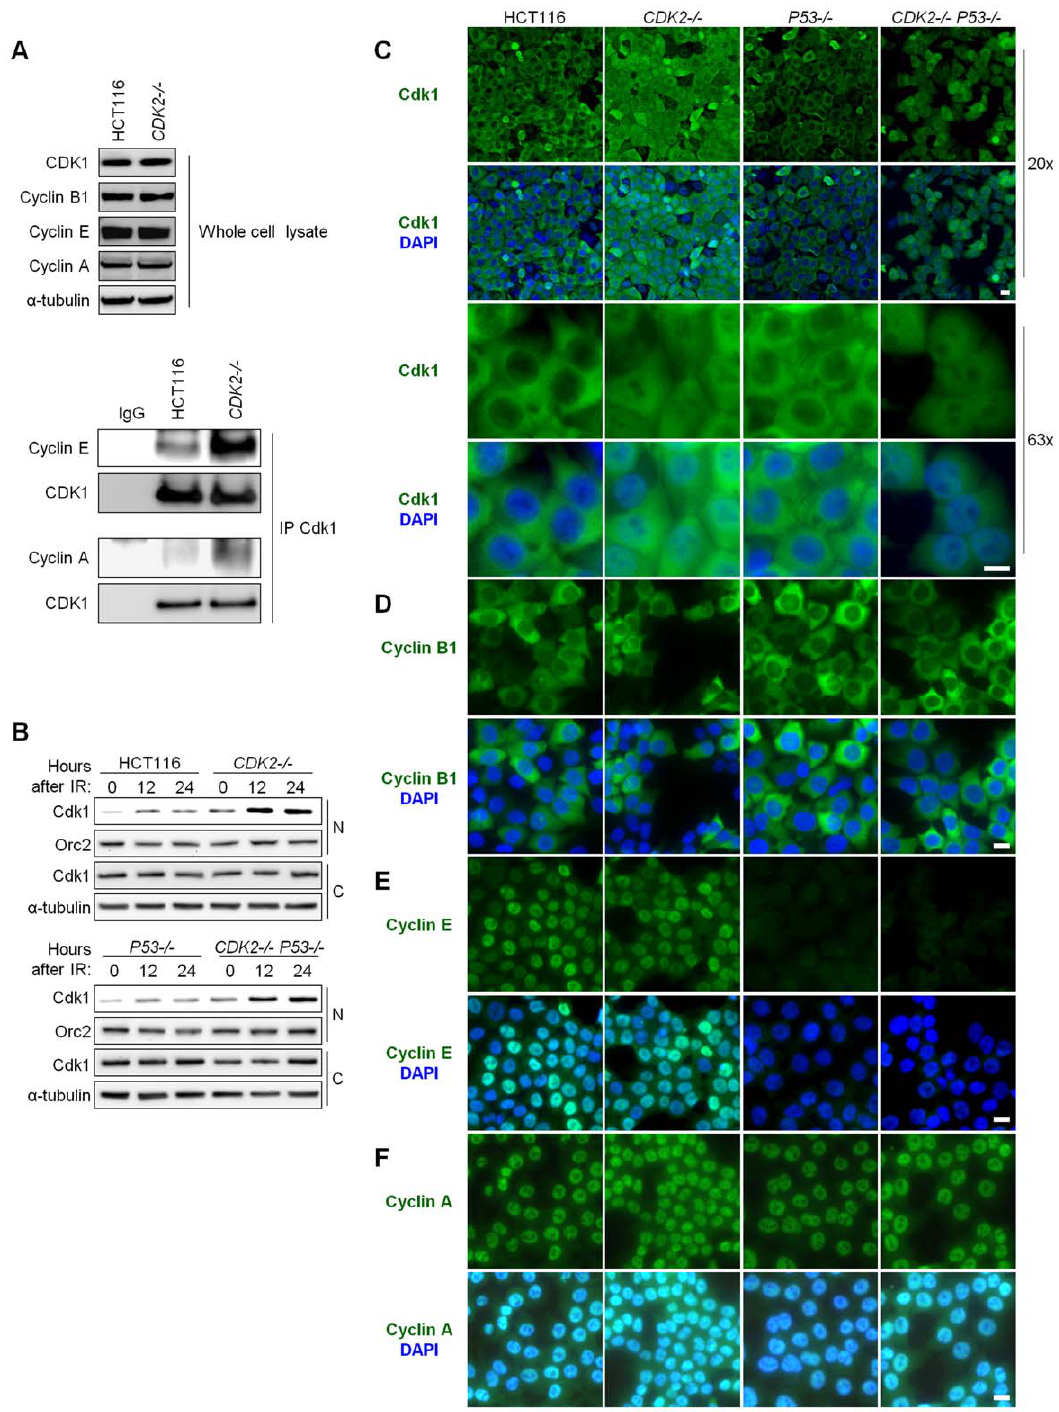
Figure 3. Aberrant localization of Cdk1 in Cdk2-deficient cells after IR treatment. (A) Association between Cdk1 and cyclins E and A was determined by immunoprecipitation/immunoblot. Non-denatured cell lysates were subjected to immunoprecipitation (IP) with anti-Cdk1 or control (IgG) antibodies. Samples not subjected to immunoprecipitation were analyzed as whole cell lysate. Levels of Cdk1 and cyclins B1, E, and A were determined by immunoblot. (B) Cdk1 levels in nuclear and cytoplasmic fractions were determined by immunoblot at the indicated times after treatment with 12 Gy IR. Loading of nuclear and cytoplasmic proteins was assessed by probing levels of Orc2 and a -tubulin, respectively. (C) Localization of Cdk1 by indirect immunofluorescence. Isogenic HCT116 cells were fixed 24 h after treatment with 12 Gy IR, stained with Cdk1 antibody (green) and counterstained with DAPI (blue). Representative fields are shown under low (20 6 ) and high (63 6 ) magnification (scale bar, 50 m m under 20 6 magnification and 10 m m under 63 6 magnification). (D–F) Localization of cyclins by indirect immunofluorescence. Isogenic HCT116 cells were fixed 24 h after treatment with 12 Gy IR, stained with (D) cyclin B1, (E) cyclin E or (F) cyclin A antibodies (green) and counterstained with DAPI (blue). Representative fields are shown under 40 6 magnification (scale bar, 10 m m).